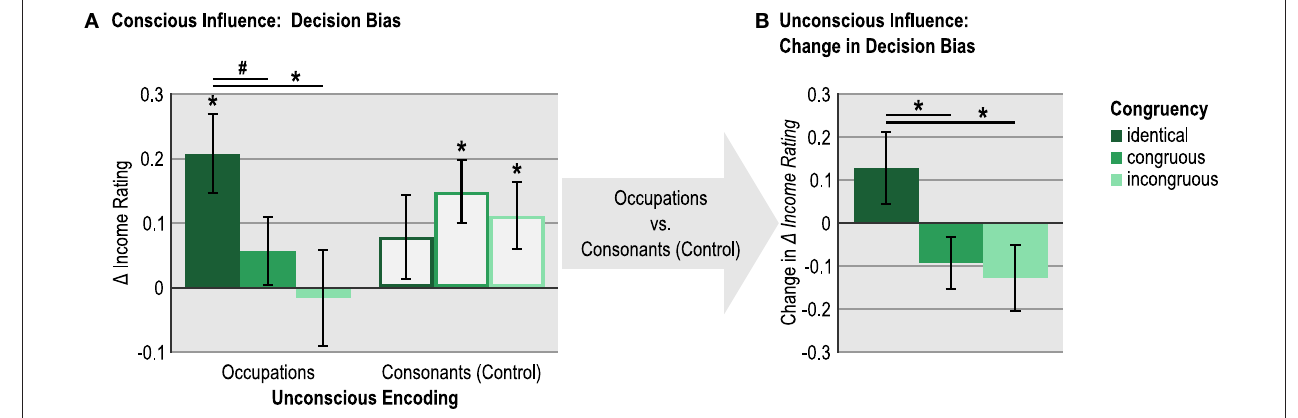
FIGURE 3 | Influences of unconscious and conscious encoding on decision-making. (A) Plotted is the difference in income ratings for faces consciously encoded with high- vs. low-wage occupations (i.e., [high]-[low]). This difference reflects the decision bias toward consciously encoded occupations. Results are shown for the between-subjects manipulated experimental condition (identical, congruous, incongruous) and the within-subject manipulated unconscious encoding condition (faces with occupations vs. consonants). The figure illustrates a strong decision bias following unconscious and conscious encoding of identical information, and a reduced or absent bias following encoding of congruous or incongruous unconscious and conscious information. (B) Plotted is the change in the bias toward consciously encoded occupations ([high]-[low]) for faces that were unconsciously encoded with occupations instead of consonant strings (i.e., [bias for faces encoded with occupations]-[bias for faces encoded with consonant-strings]). This change reflects the unconscious influence on decision bias: positive scores indicate increased, negative scores decreased decision bias toward the consciously seen occupations due to subliminal encoding of face-occupation pairs. The figure illustrates